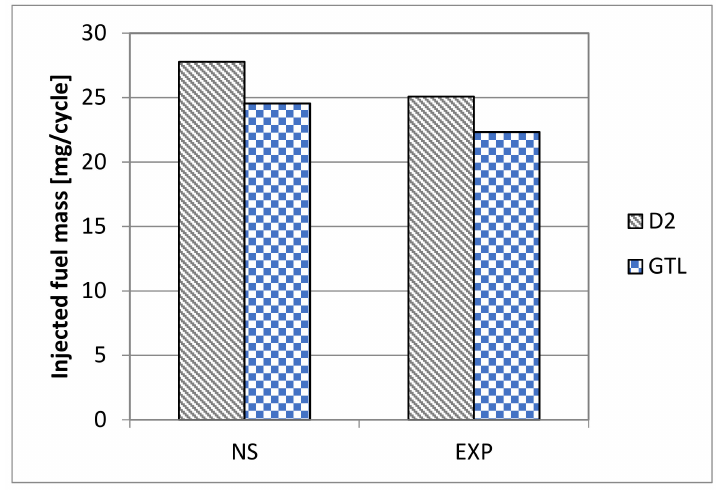
Figure 6. Numerically and experimentally obtained results of total injected fuel mass per